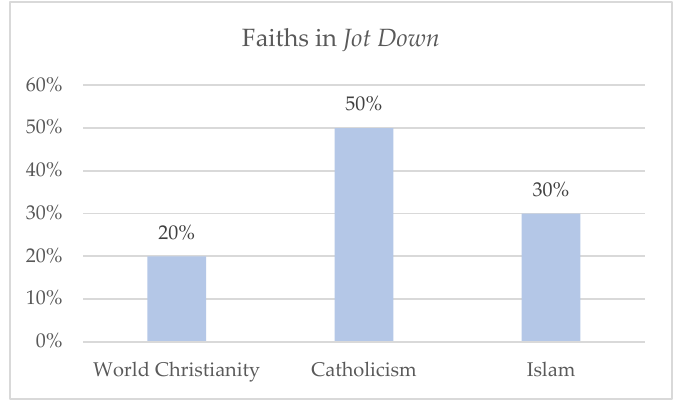
Figure 4. Predominant faiths in articles in Jot Down .